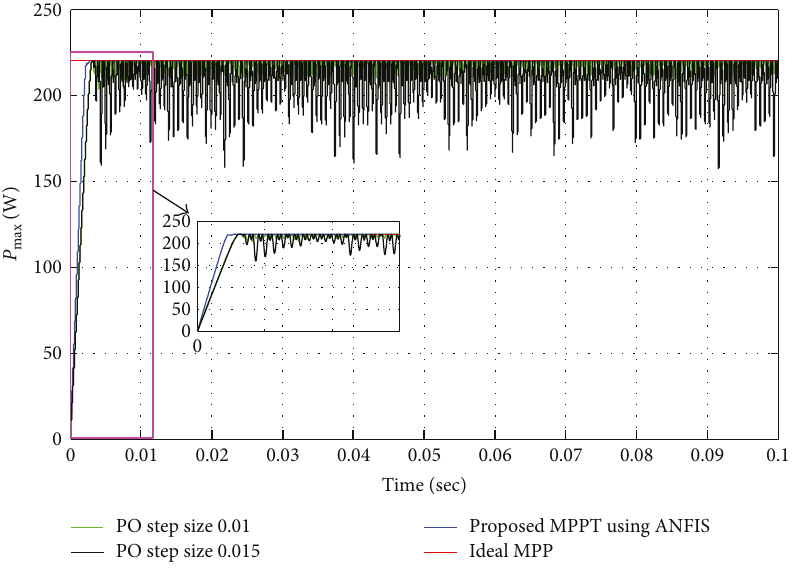
Figure 15: MPP tracking performance at constant weather conditions.